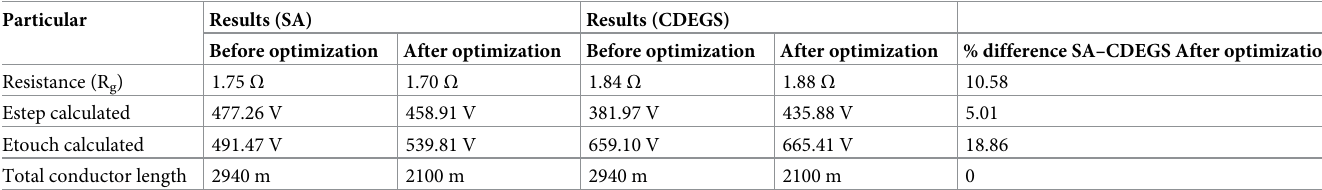
Table 17. Results for grounding system in vertical two-layer soil ( ρ 1 > ρ 2 ).